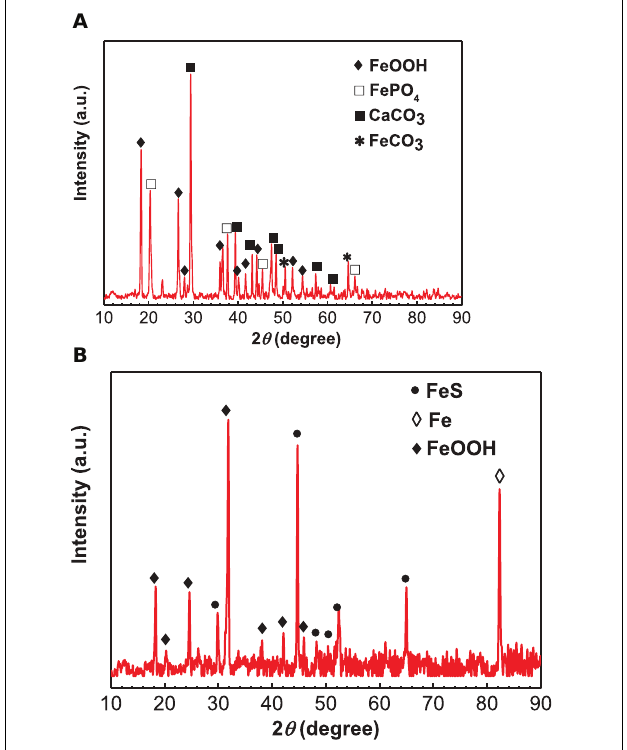
FIGURE 5 | X-ray diffraction analysis of corrosion products on specimens covered with deposit in the absence (A) and presence of SRB (B) after 14 days of incubation in CO 2 -saturated simulated formation